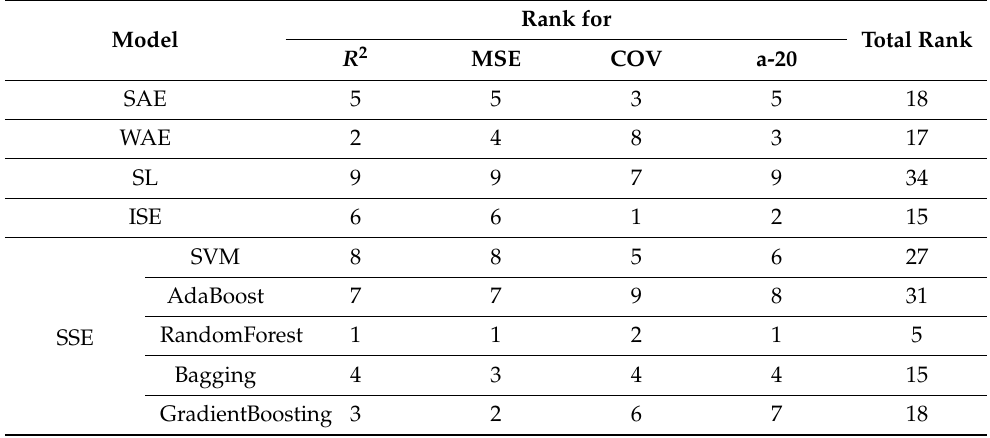
Table 7. Final ranking of the various